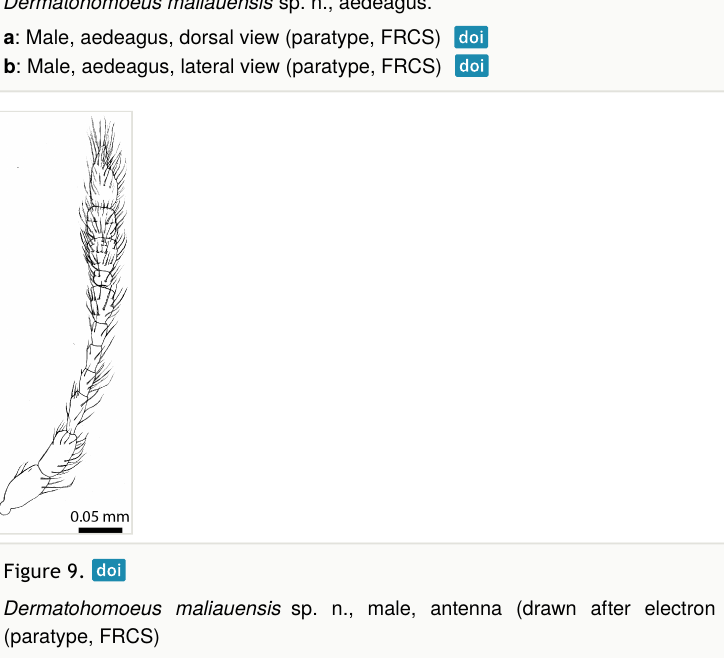
Figure 8. Dermatohomoeus maliauensis sp. n., aedeagus.